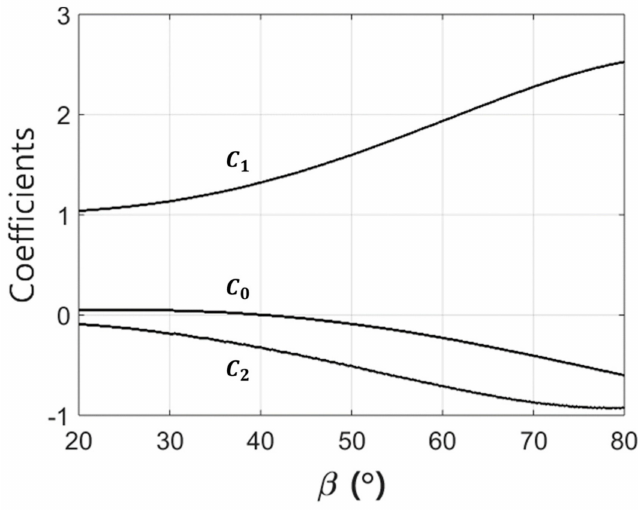
Figure 2. Coefficients of parabolic bay shape equation